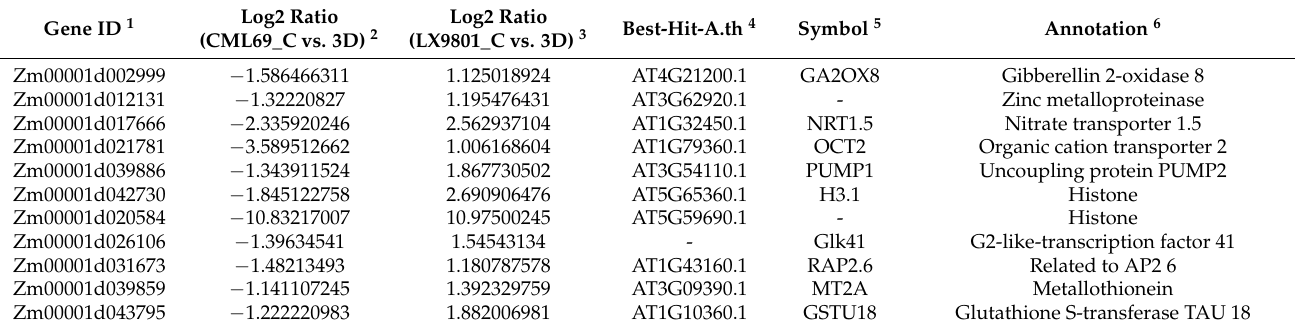
Table 6. Eleven drought-responsive DEGs downregulated in CML69 but upregulated in LX9801 at 3D drought stress.